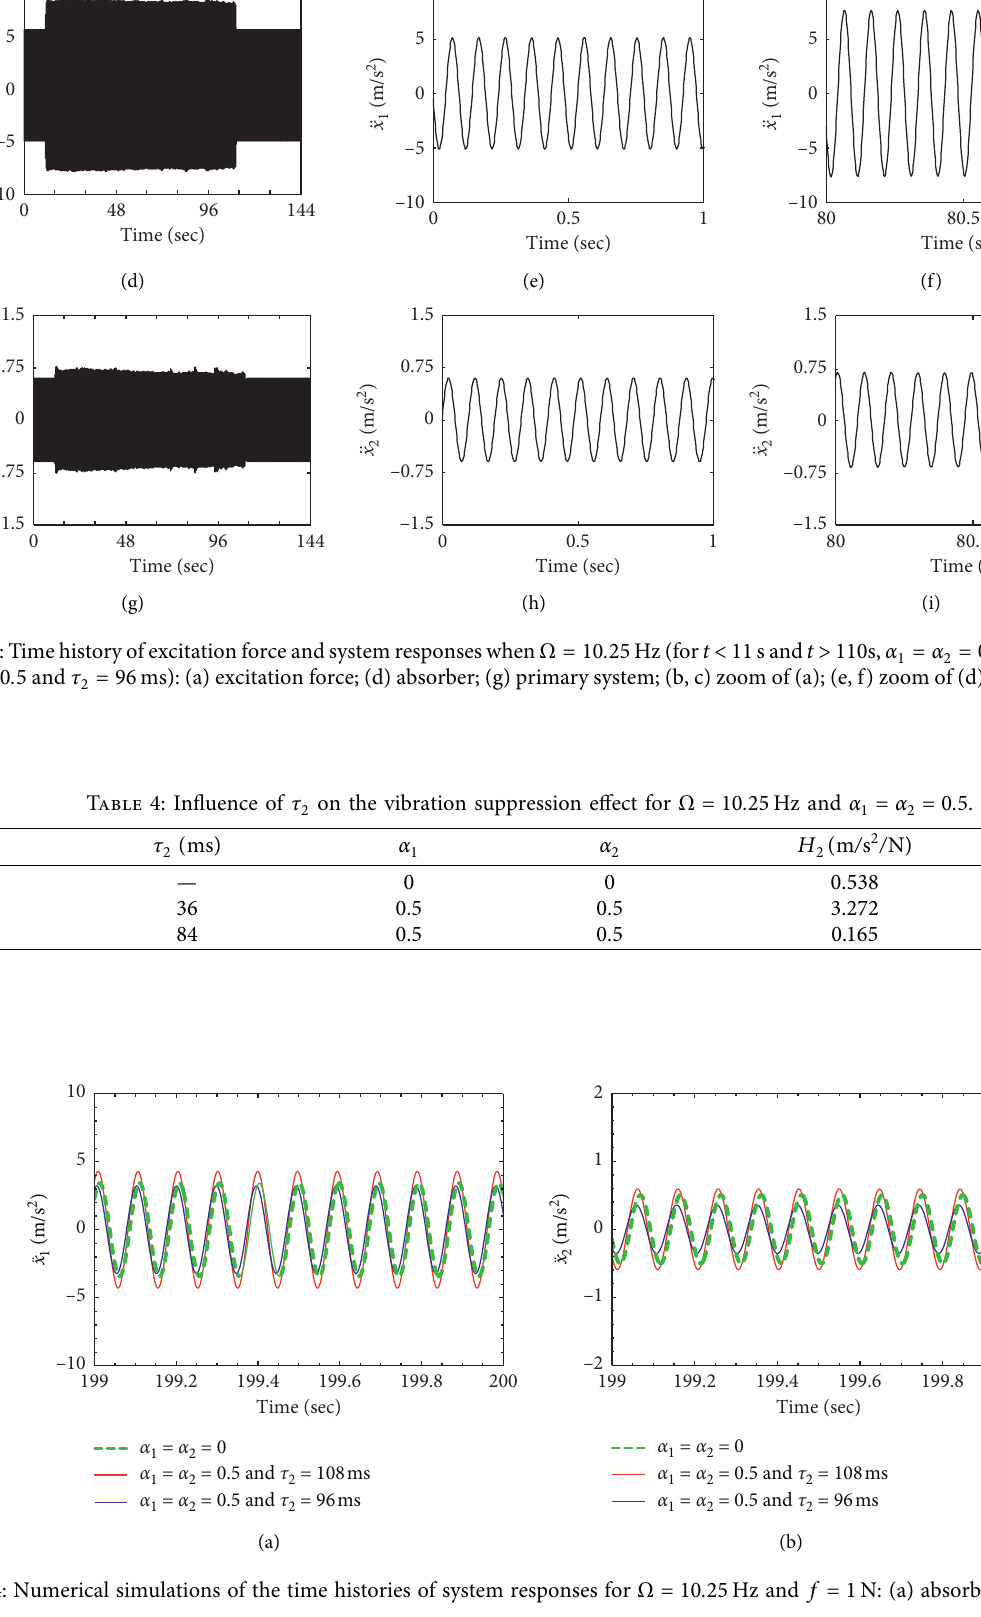
Figure 14: Numerical simulations of the time histories of system responses for Ω � 10 . 25 Hz and f � 1N: (a) absorber and (b) primary